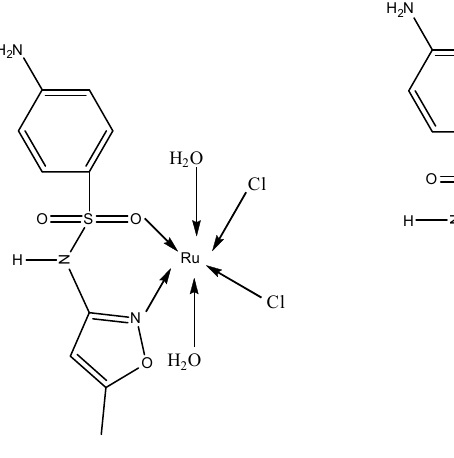
Scheme 1. SMX coordination mode with Ru(III), Pt(IV), and